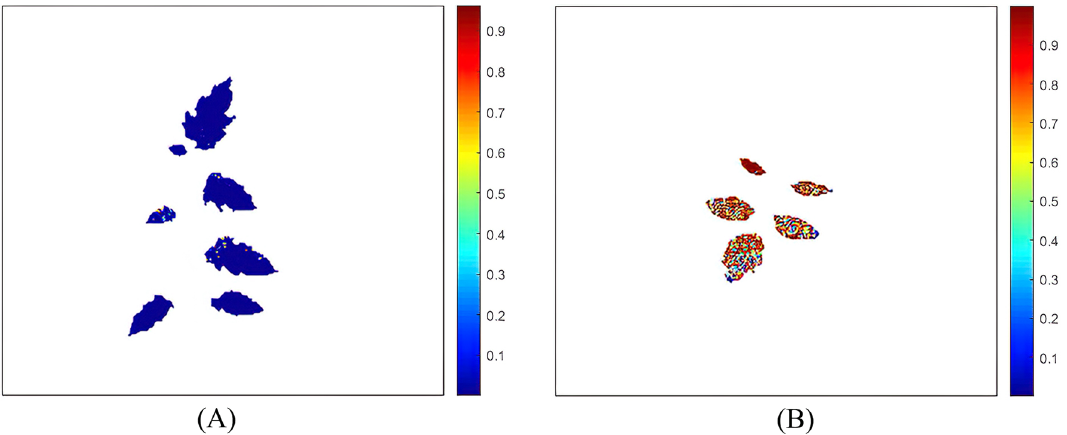
Figure 7. Visualization of leaf infection: ( A ) Healthy A; ( B ) Infected D (corresponds to healthy A and infected D in Table 4).